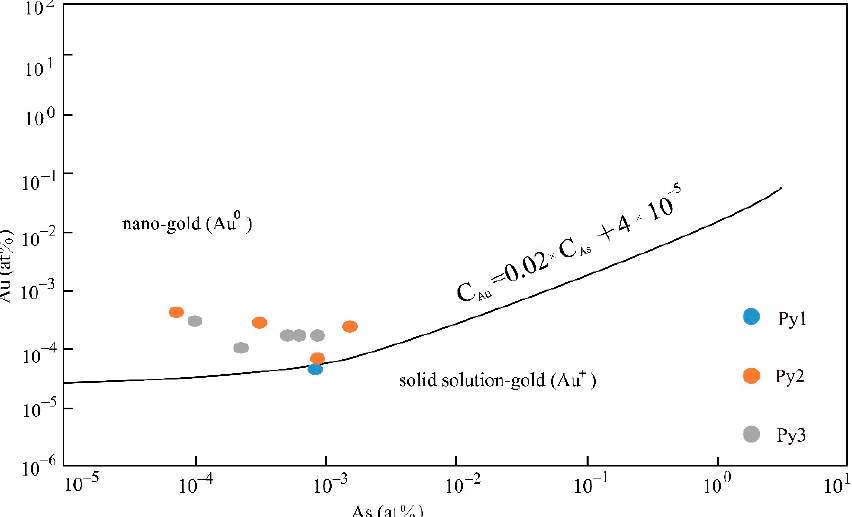
Figure 9. Relationship diagram of As and Au content in pyrite (atomic percentage, fitting equation according to